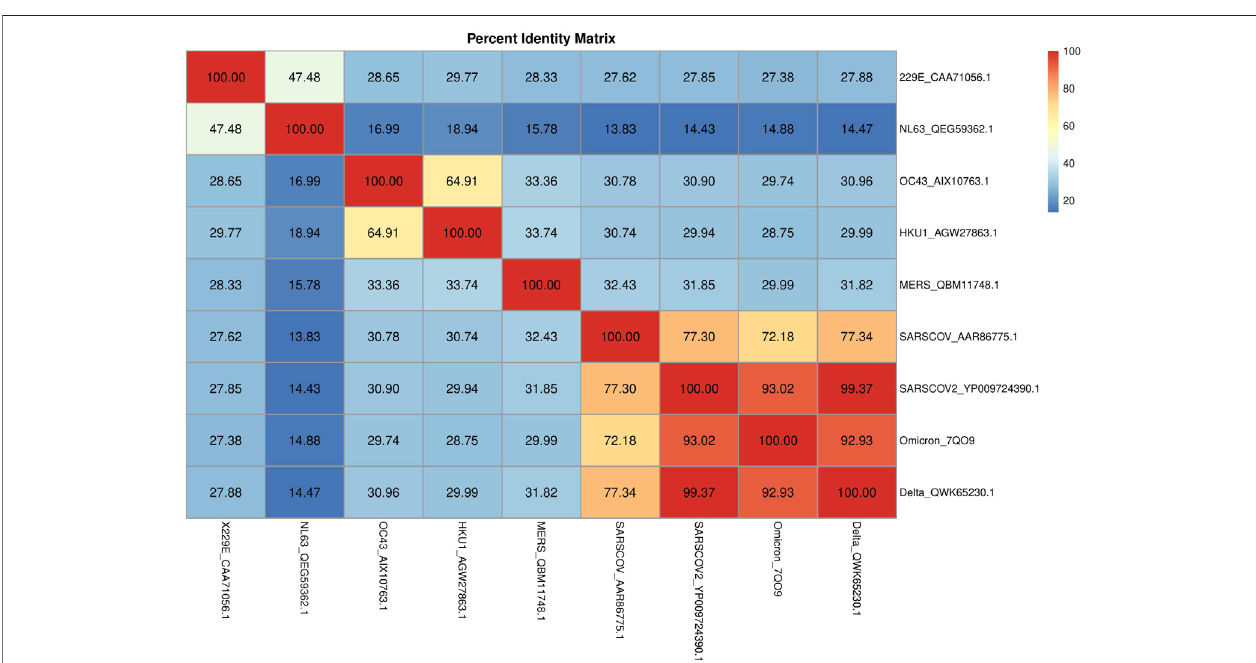
FIGURE 5 | Percent identity matrix. In A, the percent identity matrix is reported, which shows the % of identities among the S proteins of HCoVs.